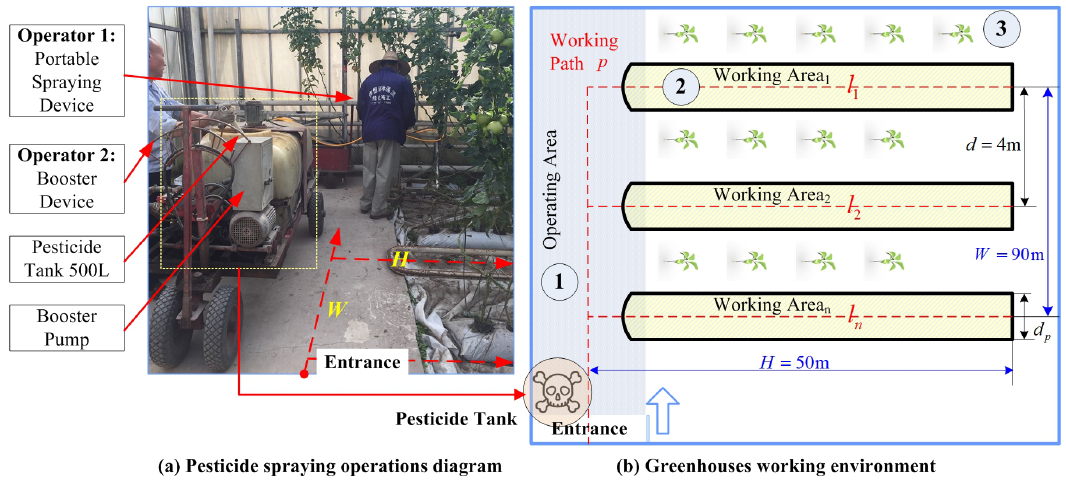
Figure 1. Overview of greenhouse application case.